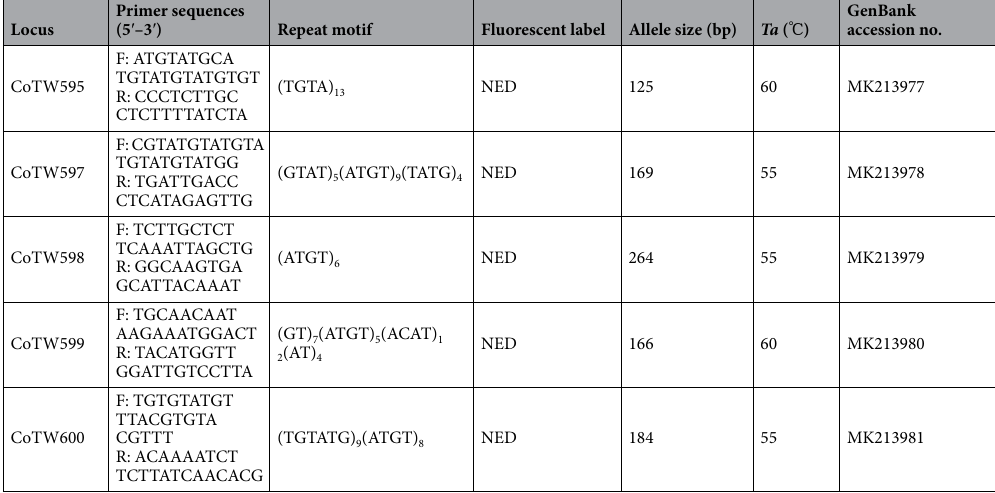
Table 1. Characteristics of 23 gSSR loci developed in Chamaecyparis taiwanensis . Ta annealing temperature, TD touchdown